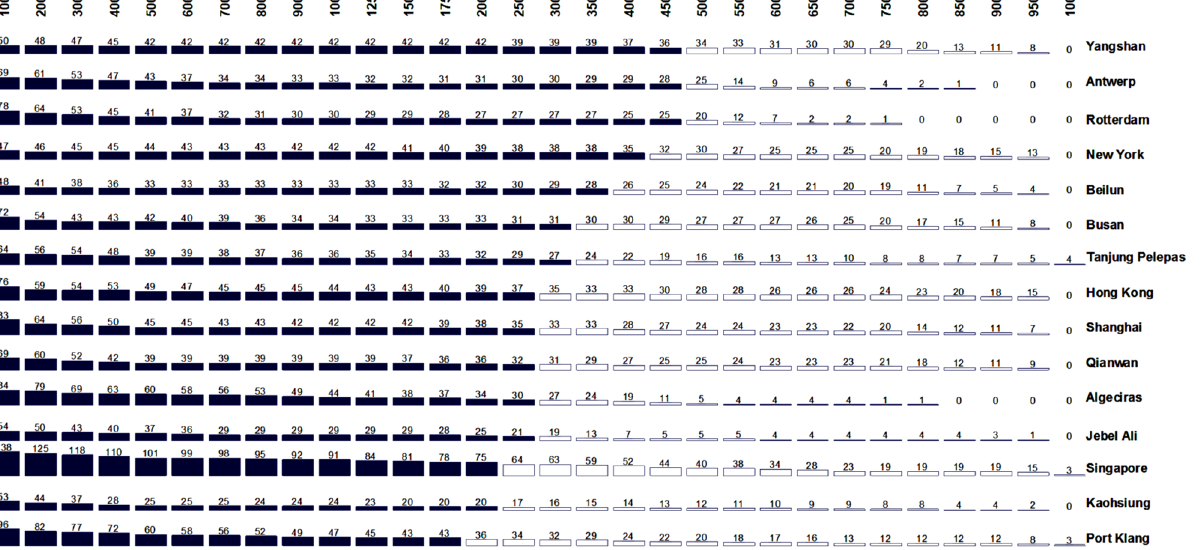
Figure 3. Bar charts of node degree across the available 32 GCSN layers (expressing node degree as a function of distance), for the selected ports shown in Table 2 (bar heights are proportional to the degree; dark bars represent values higher than row’s